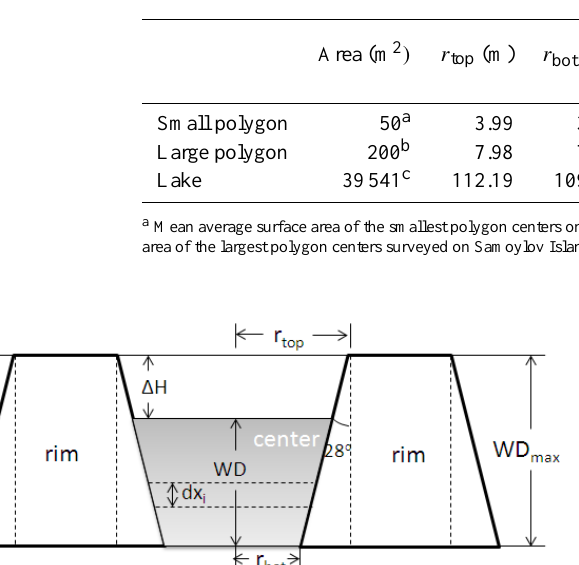
Table A1. The area, top radius ( r top ) , bottom radius ( r bot ) , maximum water depth (WD max ) of polygons or lakes, and their volumetric water contents (vwc) at the top and bottom.